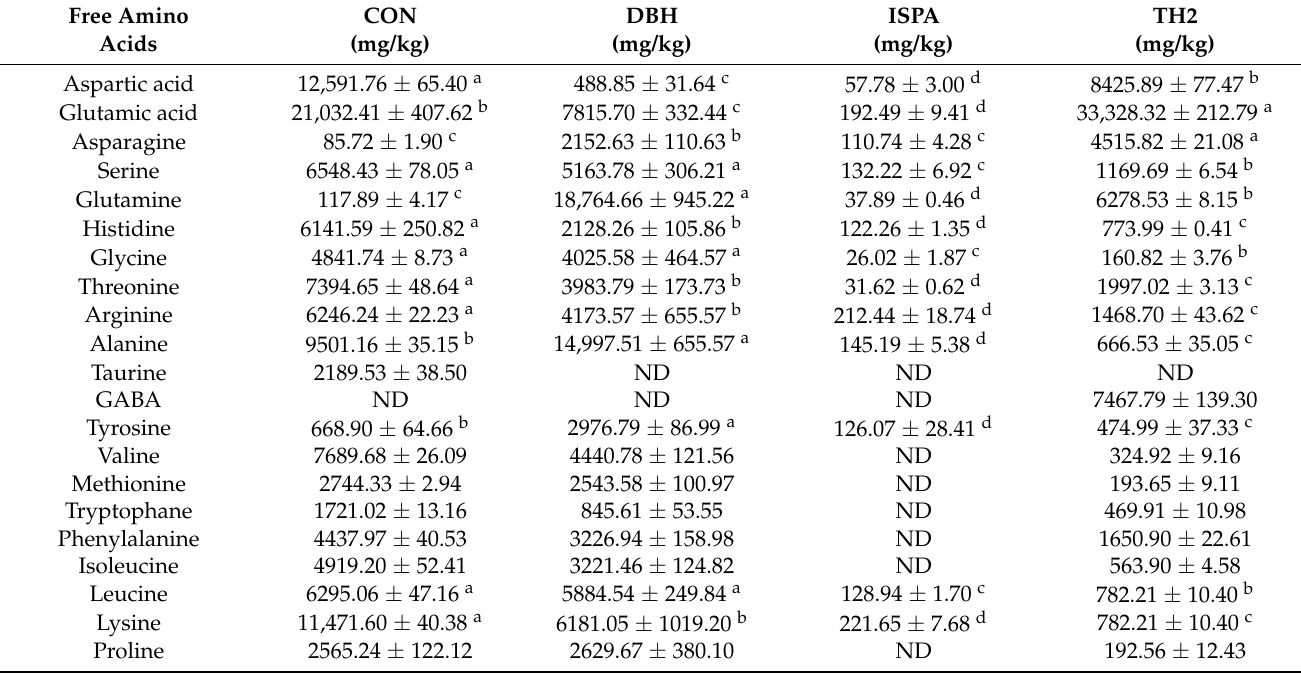
Table 4. Free amino acid composition of jeotgal